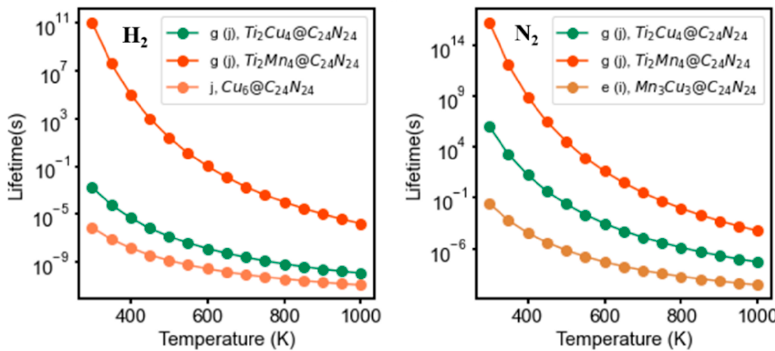
Figure 9. The calculated lifetime of the adsorbed gas species on Ti x Cu z @C 24 N 24 , Ti x Mn y @C 24 N 24 , and Mn y Cu z @C 24 N 24.